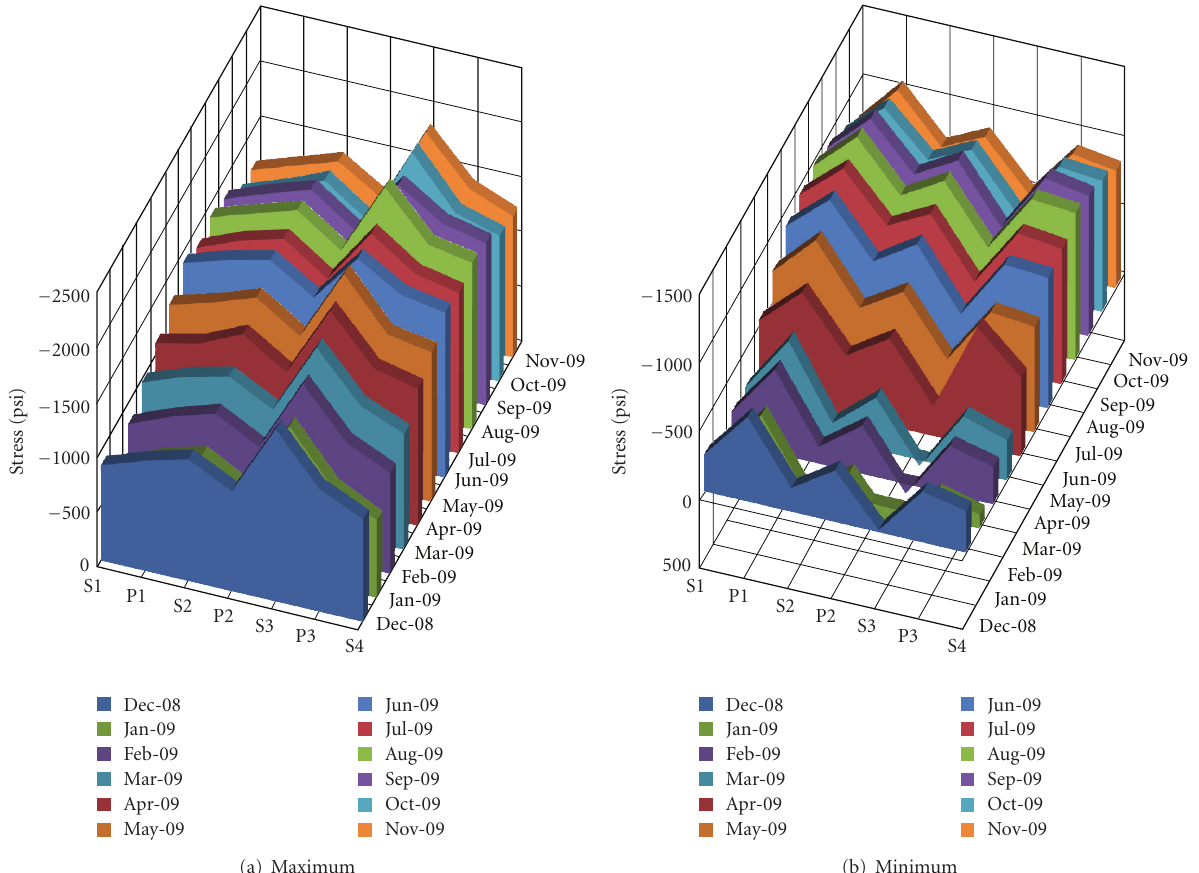
Figure 13: Maximum and minimum transverse stresses (psi)—south